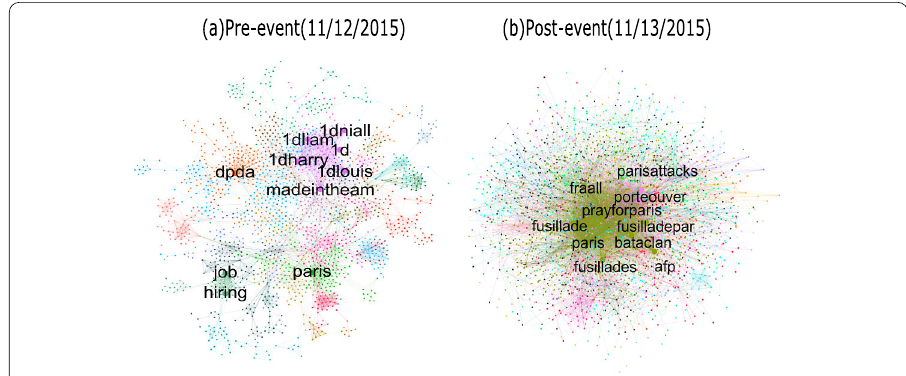
Figure 1 Collective attention shift. The sudden change in users’ attended topics at the collective level after the 2015 Paris attacks event is revealed by the ‘attention shift